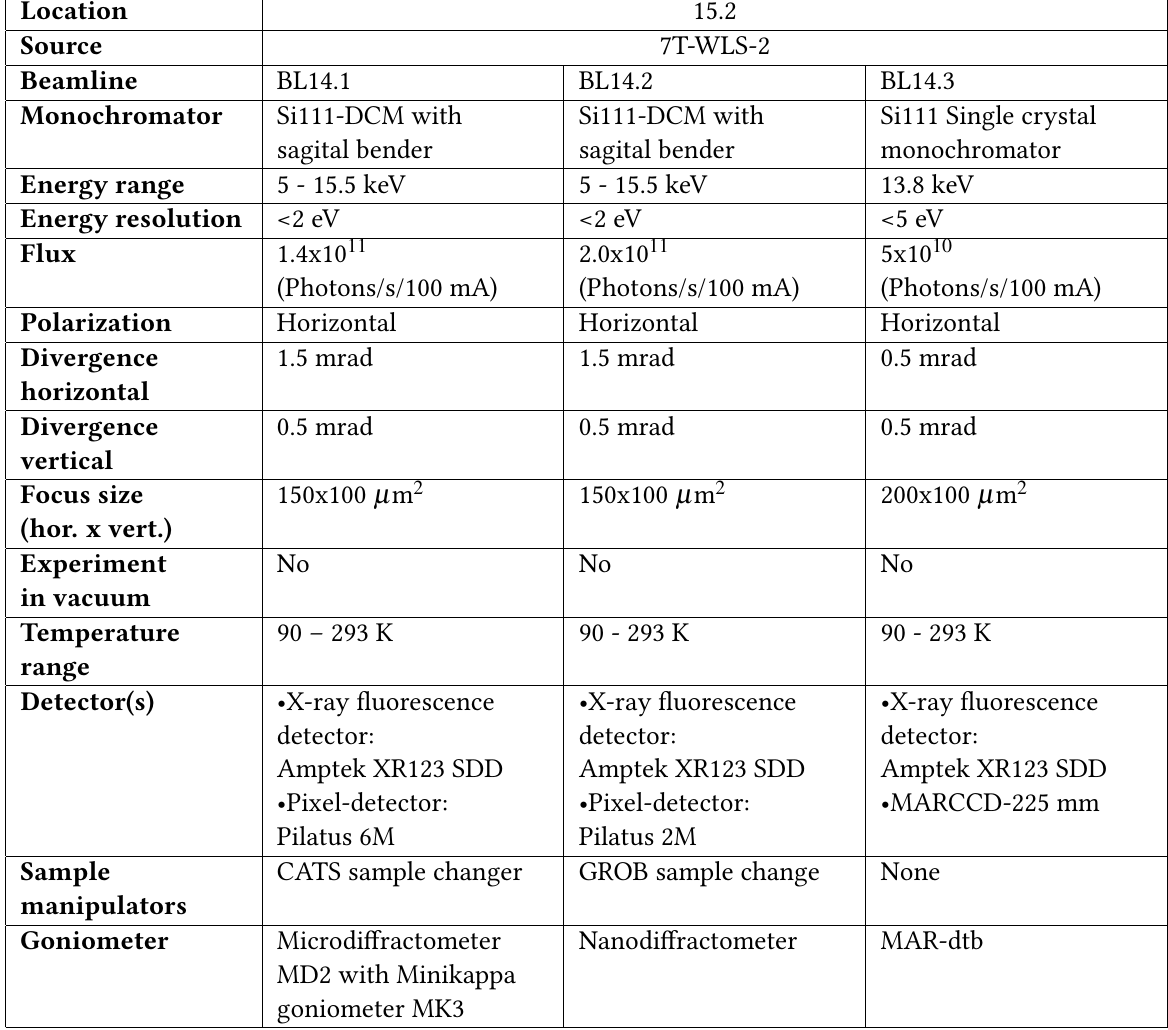
Table 2: Parameters of the